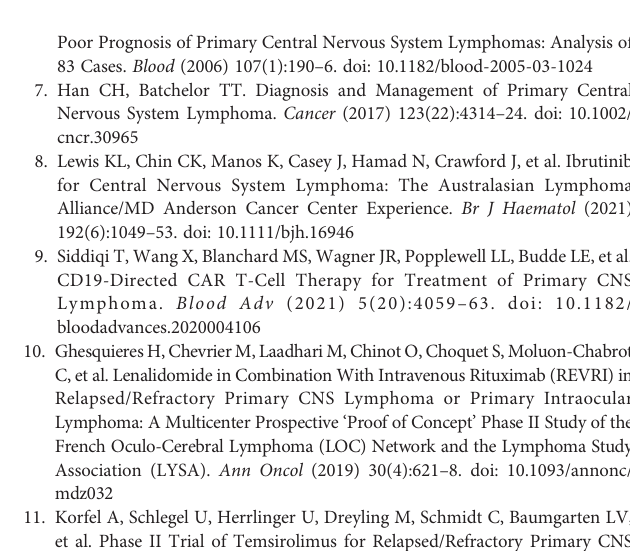
Supplementary Figure 1 | (A) The effect of extent of surgery on OS in PCNSL patients. (B) The effect of extent of surgery on DSS in PCNSL patients. The total resection was signi fi cantly associated with better OS and DSS than partial resection, P <